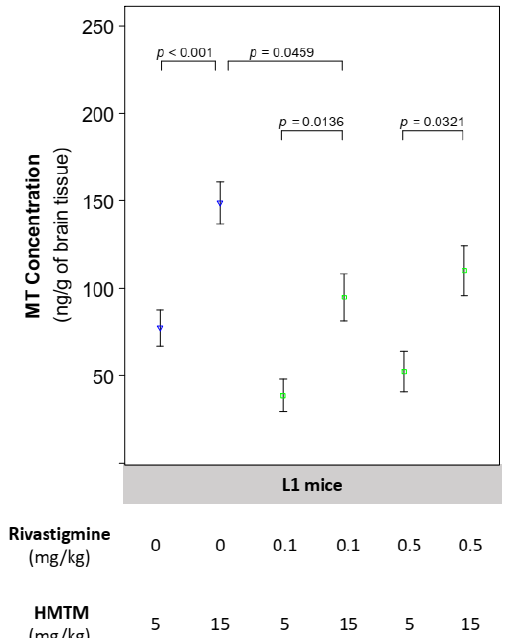
Figure 2. Brain concentrations of MT in L1 mice. For L1 mice administered solely HMTM at 15 mg/kg, there was a significant doubling in the brain concentration of MT when compared to mice injected with 5 mg/kg ( p < 0.001). When HMTM was co-administered with rivastigmine, the brain concentration of MT was decreased ( p = 0.0459, L1 rivastigmine 0.1 mg/kg + HMTM 15 mg/kg vs. L1 HMTM 15 mg/kg). Nevertheless, the proportional increase between both HMTM doses was maintained independently of the dose of rivastigmine being administered (0.1 mg/kg, p = 0.0136; 0.5 mg/kg, p = 0.0321). Increasing the dose of rivastigmine from 0.1 to 0.5 mg/kg produced no difference between L1 mice receiving the same dose of HMTM. Data are expressed as mean values ± SEM ( n = 5–12). Differences are considered statistically significant when p < 0.05. Regardless of the doses, the blue symbols represent the experimental groups dosed with HMTM; and the green symbols represent the groups dosed with both HMTM and